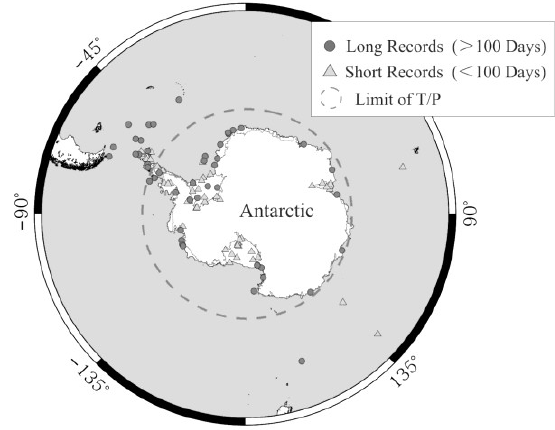
Figure 4. Locations of all tidal measurements. The circle at 66°S is the southern limit of T/P altimetry, dots stand for those records longer than 100 days, and triangles stand for those records shorter than 100